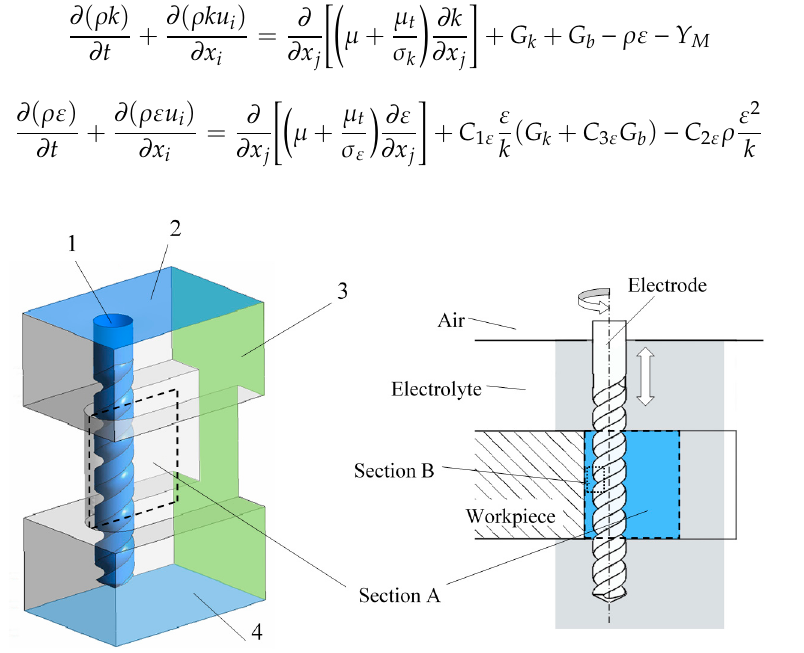
Figure 3. The flow field model of the electrolyte in the machining gap.